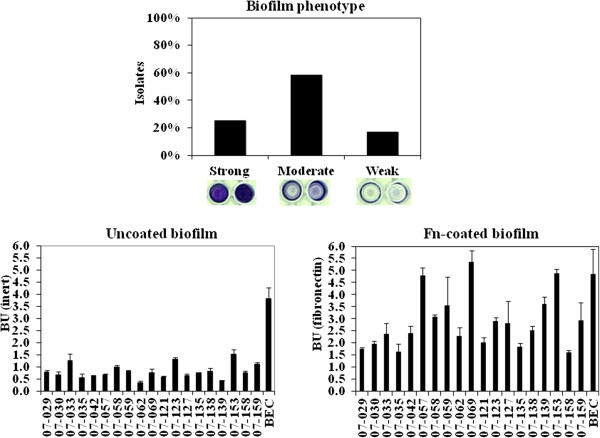
Biofilm formed by ST1 isolates. Top: Percentage of the total 60 ST1 isolates displaying strong, moderate and weak biofilm phenotypes. Wells show the different biofilm phenotypes formed on inert polystyrene surfaces by representative ST1 isolates. Bottom: Biofilm formed on inert or fibronectin-coated surfaces by 19 ST1 isolates.